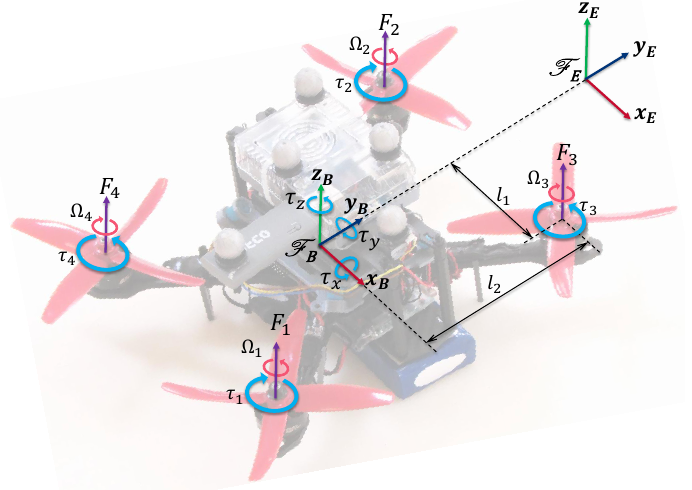
Figure 1. Custom-made quadrotor of interest. Notation: F i and τ i are the force and torque generated by i th rotor with Ω i angular velocity; τ x , τ y , τ z are the external moments about x -, y -, z -axes,